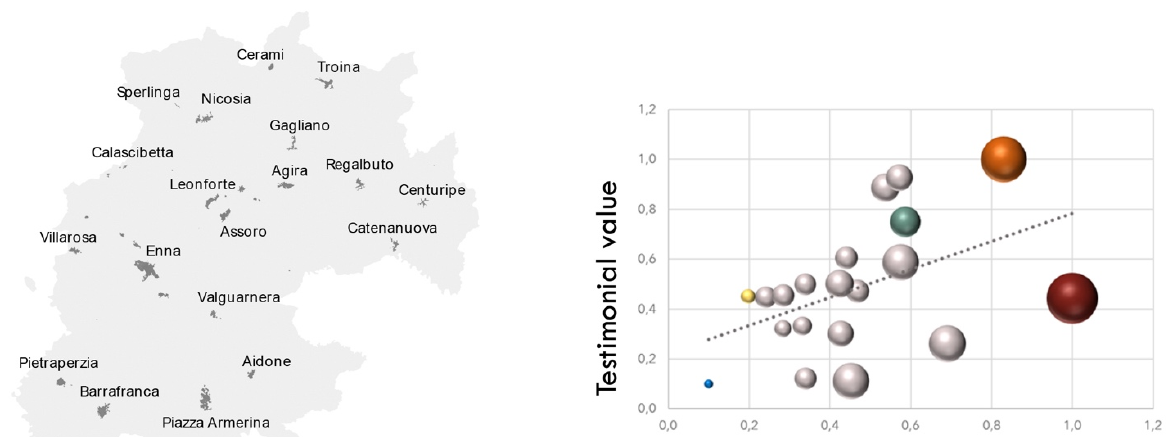
Figure 12. Maps and correlations of Economic capital and Urban area testimonial value over the 20 municipalities (numerical values under the colour ramp).